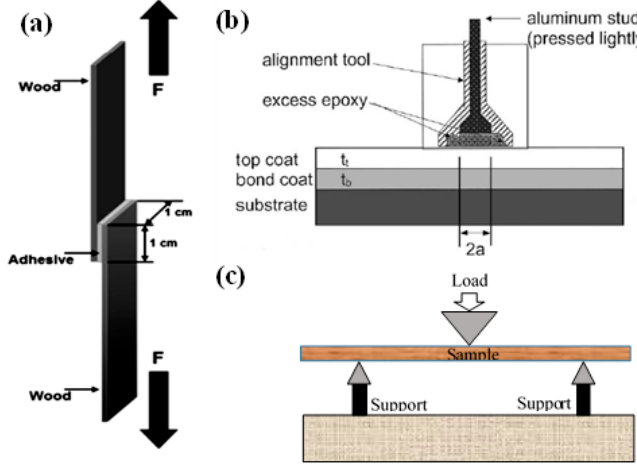
Figure 8. Schematic of wood adhesive ( a ) shear strength test [137], Reproduced with permission from Elsevier; ( b ) pull-off strength test [130], Reproduced with permission from Elsevier; and ( c ) three-point bending strength test.